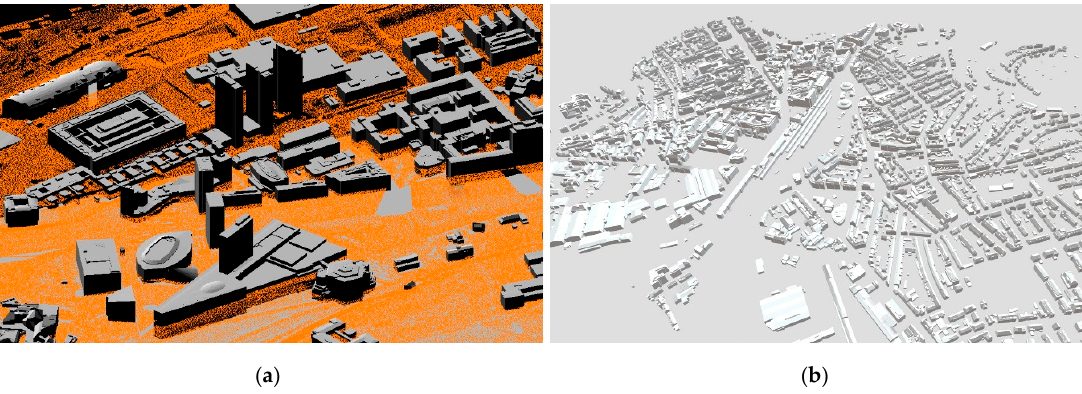
Figure 9. A 3D model (LoD2) of the buildings in Luxembourg City based on ALS point cloud (2019); ( a ) business district at the northeast (Kirchberg) with public buildings; ( b ) southern part of the city near the central station.